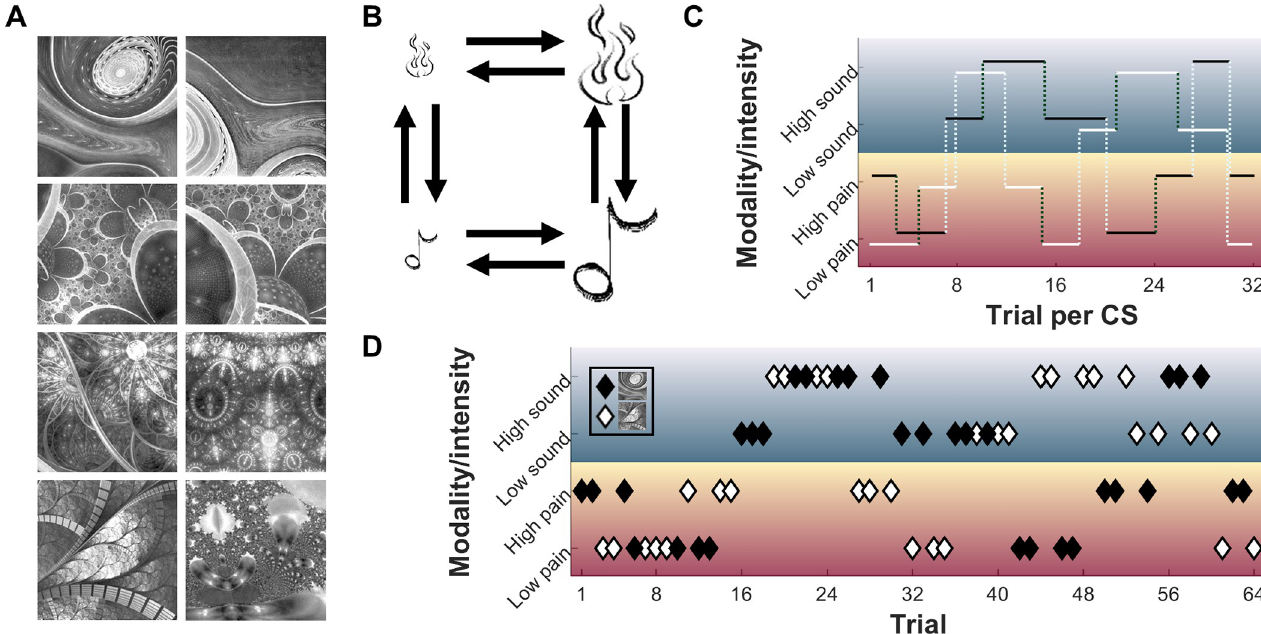
Fig 2. Learning protocol aspects of the experiment. (A) Set of CS; 2 were randomly selected for each participant (constraint: stimuli in row 2 could never both be selected due to high similarity). (B) Possible US associated with a CS at any particular trial (low pain, high pain, low sound, and high sound). Arrows indicate possible reversals; notably, no combined intensity and modality (cross)reversals occurred. (C) Example for contingencies of CS1 (black solid line) and CS2 (white solid line) for their 32 trials per session each. Vertical dotted lines indicate reversals, with light dotted lines for modality reversals and dark dotted lines for intensity reversals. (D) Example for an actual trial sequence of 64 trials with interspersed CS1 (black diamonds) and CS2 (white diamonds) and their associated US (rows). Data used to produce the figure can be found at https://www.doi.org/10.17605/OSF.IO/7JBV3. CS, conditioned stimuli; US, unconditioned